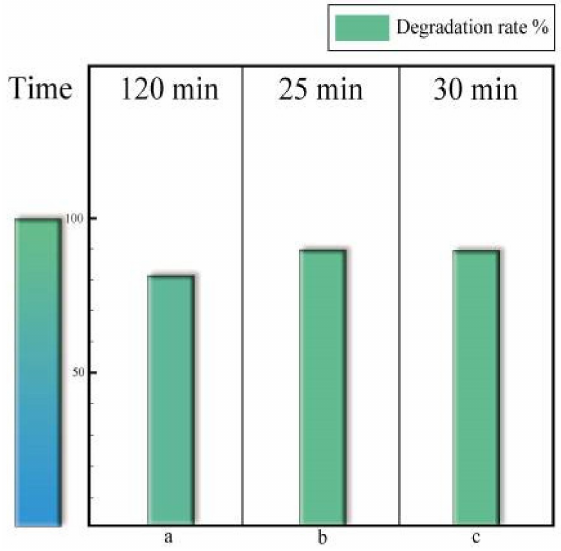
Figure 12. Degradation of NOF by three iron-based catalysts: ( a ) CoFe 2 O 4 –SAC [47], ( b ) Fe 2 O 3 @CoFe 2 O 4 [69], and ( c ) rGO–Fe 3 O 4